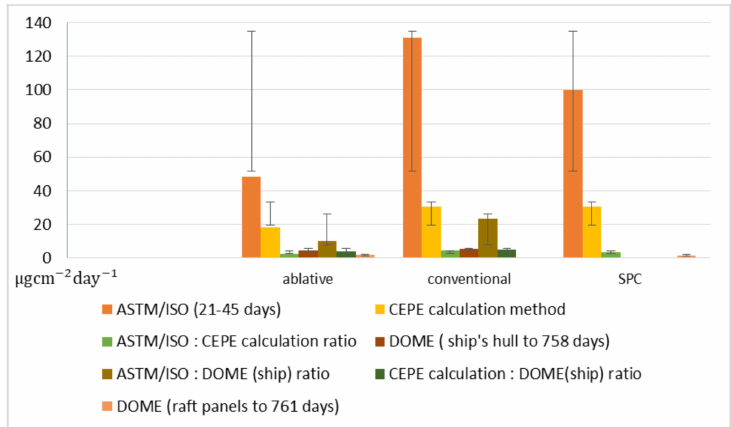
Figure 1. Copper emission results from three types of AF coatings using di ff erent methods. Source: Data from [36].